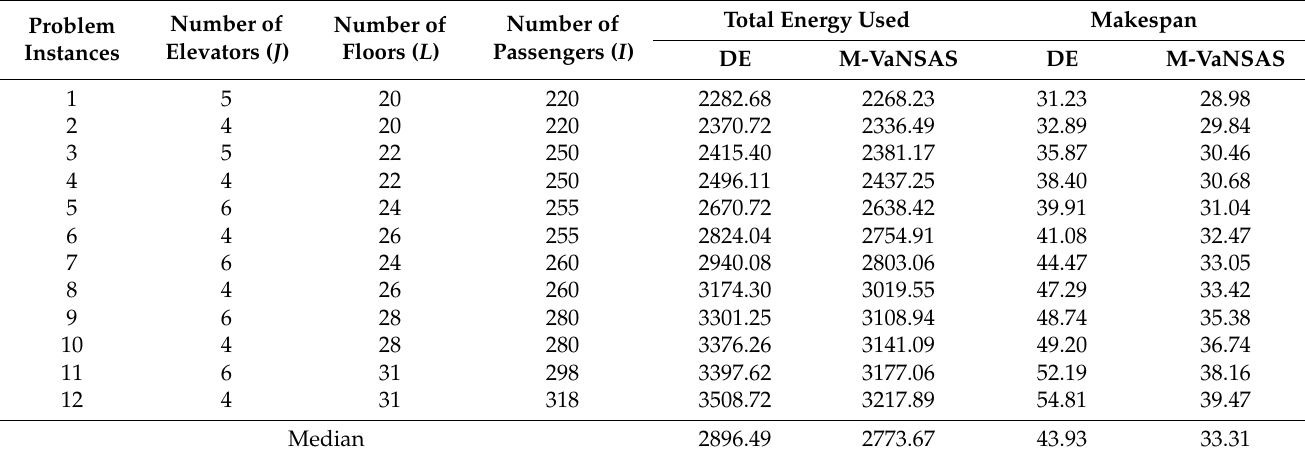
Table 9. Energy used and makespan of the elevator using w 1 = 0.7 and w 2 = 0.3.